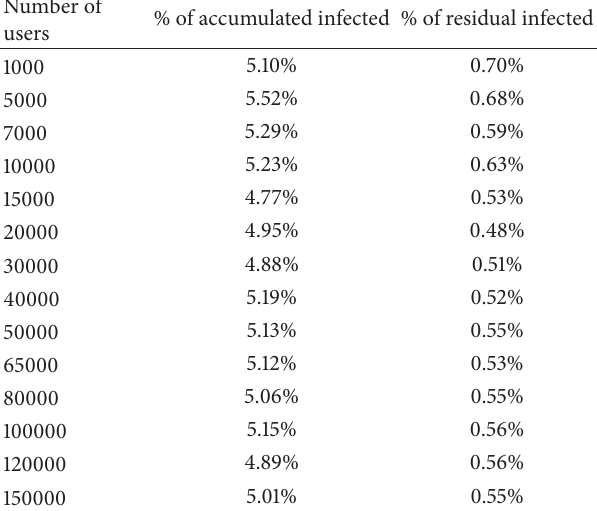
Figure 2: App-Model flowchart. In this figure we describe the evolution process of the model from 𝑡 = 0 (start point) to 𝑡 = 𝑇 (end point), showing, for every time instant, the creation of the agents, the assignation of attributes, the order of performance of the methods, and their interaction. Table 9: Comparison of percentage of cumulative and residual infected users for month 𝑡 = 15 . The results are very similar.